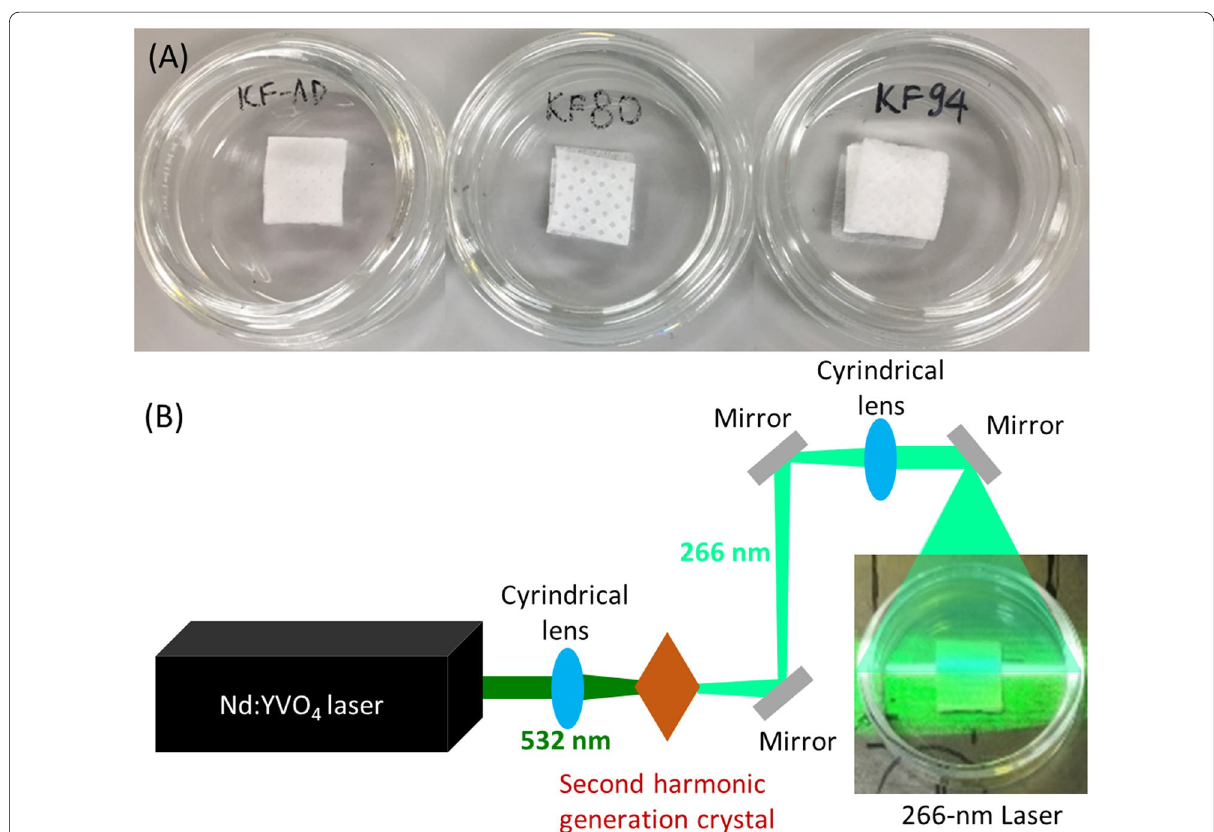
Fig. 1 A KF‑AD, KF80, and KF94 face masks (1